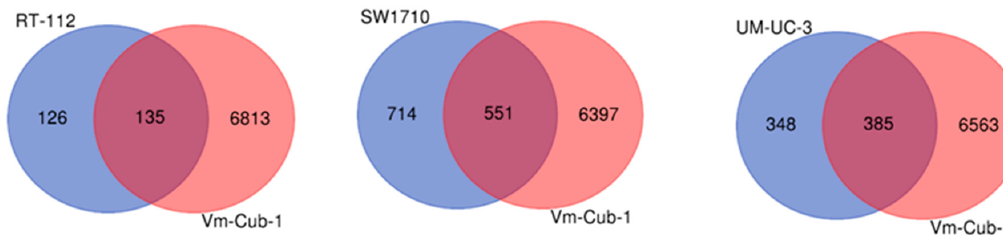
Figure 9. Venn diagram comparison of differentially expressed genes in HDAC5-transduced cell lines. Pairwise comparison of differentially regulated genes in RT112, SW1710, UM-UC-3 (from left to right, respectively) vs. VM-Cub-1. Table 1. Differentially expressed genes in HDAC5 vs. vector-only transduced UC cell lines.